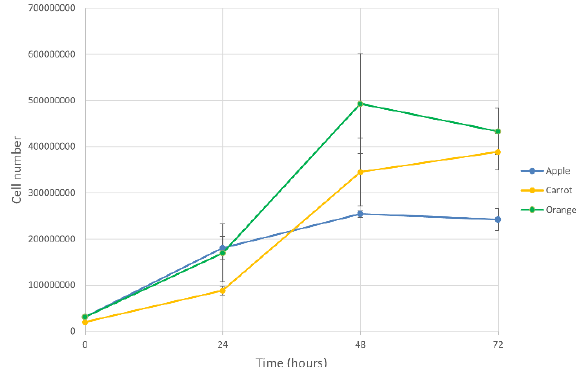
Figure 1. Average numbers of Brettanomyces bruxellensis cells counted during submerged solid-sub- strate fermentation of apple, carrot, and orange pomaces. Error bars show the standard deviation between replicates ( n = 5).